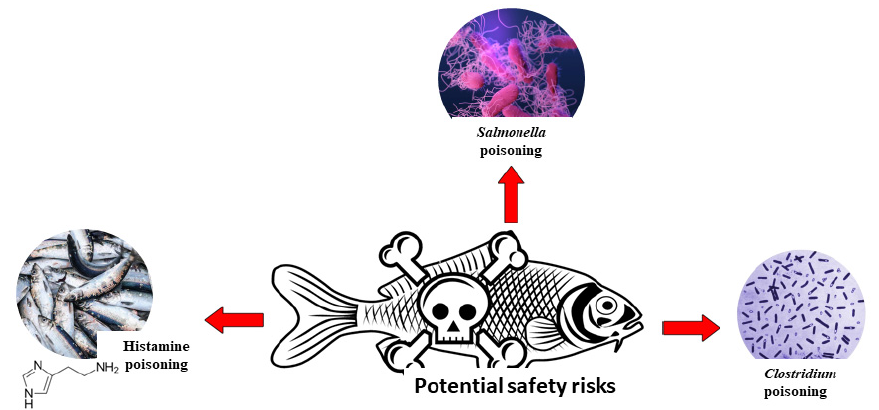
Figure 5. The potential safety risks of fermented fish consumption.